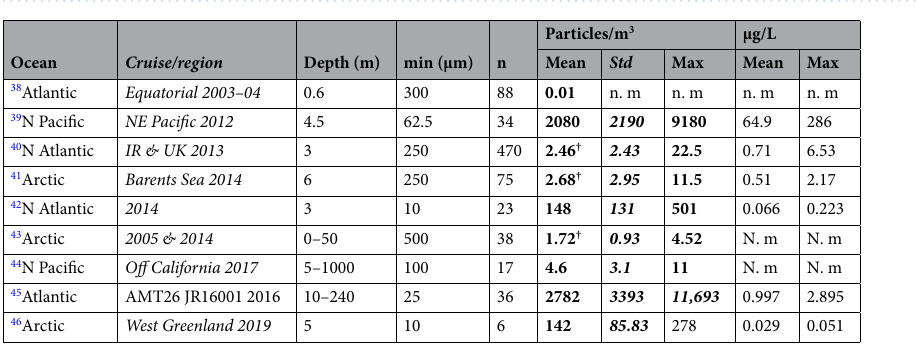
Table 2. Plastic density in sub-surface waters. When the studies report data for particles < 5 mm (microplastics) separately these values are shown here. Bold indicates measured values. Mass estimates were obtained from particle size data assuming density = 1, cylindrical shape for fibers and spherical shape otherwise. n.m. not measured or unavailable data. † > 95%